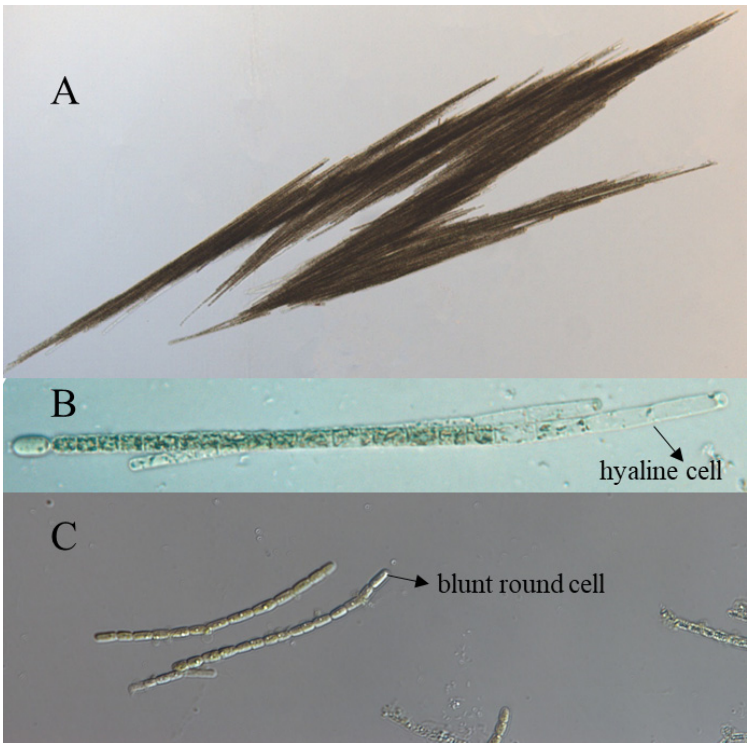
Figure 1. Morphological characteristics of the two different filamentous cyanobacteria. ( A ) outside sample of Aphanizomeon flos-aquae ; ( B ) Aph. flos-aquae had fascicle-like assemblages with elongated and hyaline terminal cells. ( C ) Aph. gracile , blunt round terminal cells characters.